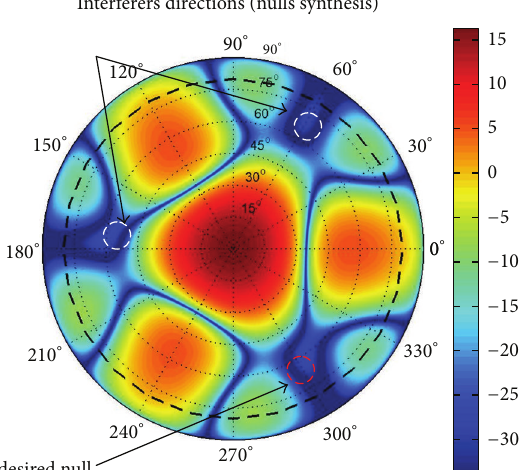
Figure 7: Single element gain versus elevation angle.